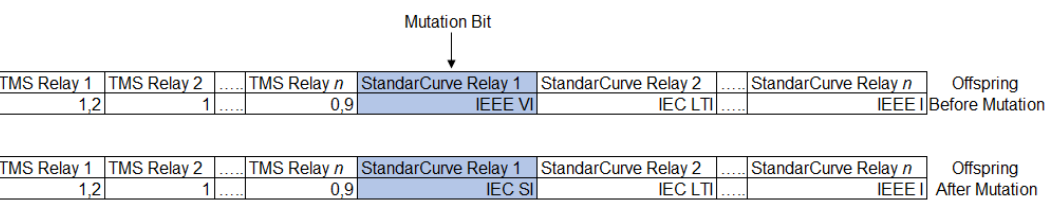
Figure 4. Example of Mutation.